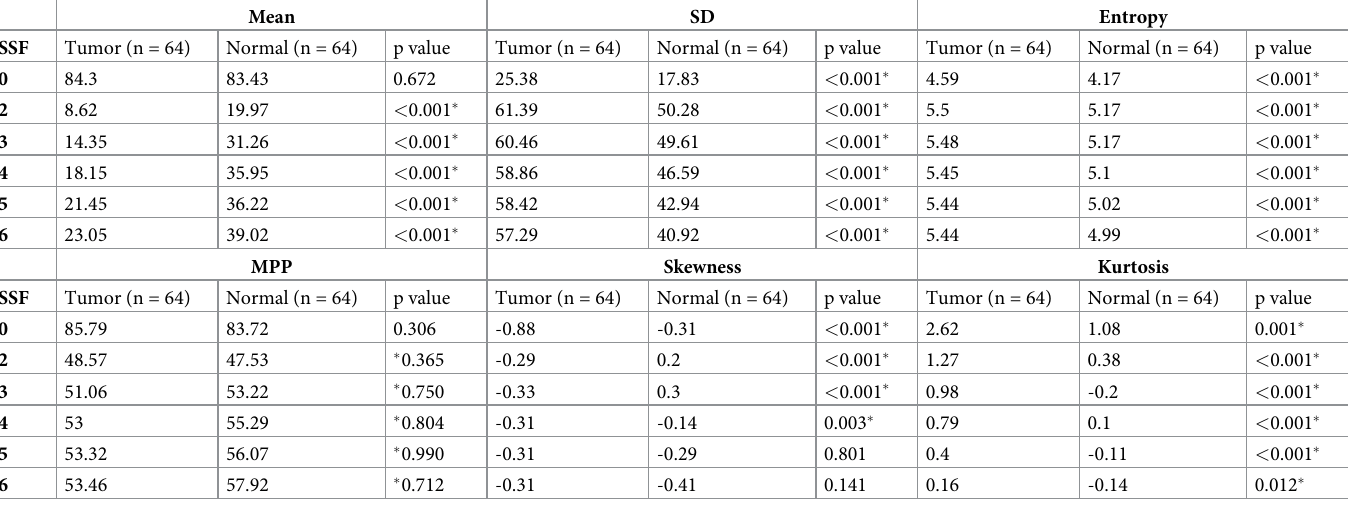
Table 2. Comparisons of texture analysis-derived parameters between normal tonsil and tonsil